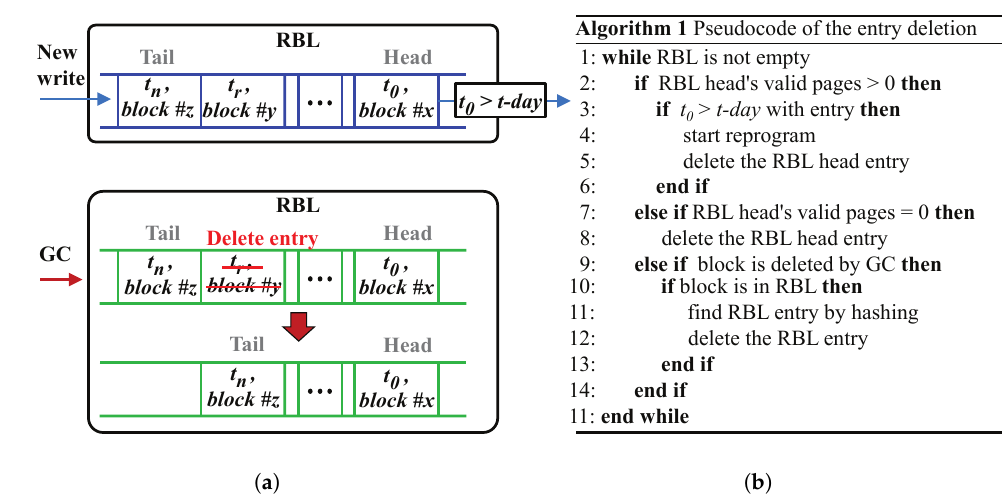
Figure 7. An operational overview of RBL. ( a ) Illustrations of RBL operation. ( b ) A sequence of entry